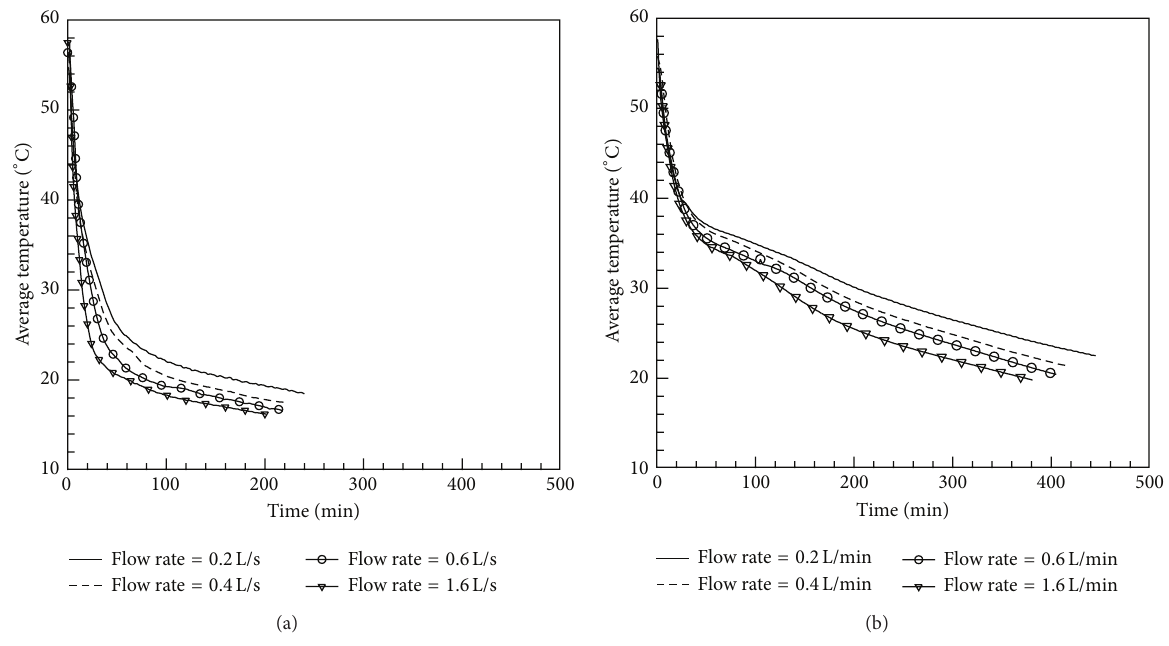
Figure 11: Comparison of average temperature profile in the PCM at various mass flow rates in discharging process: (a) finned-tube heat exchanger; (b) bare tube heat